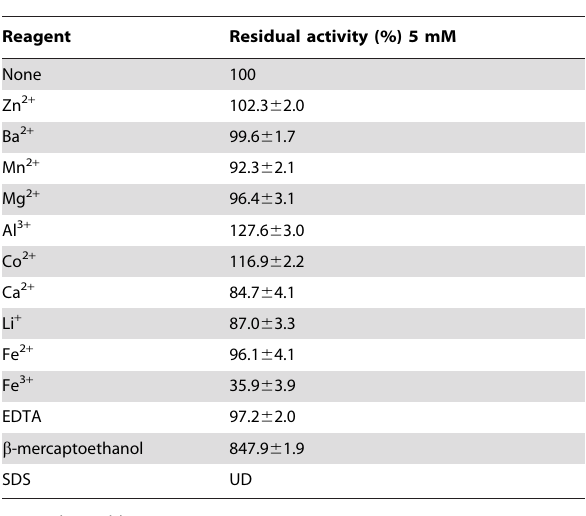
Table 3. Effect of various agents on Svi DyP activity.